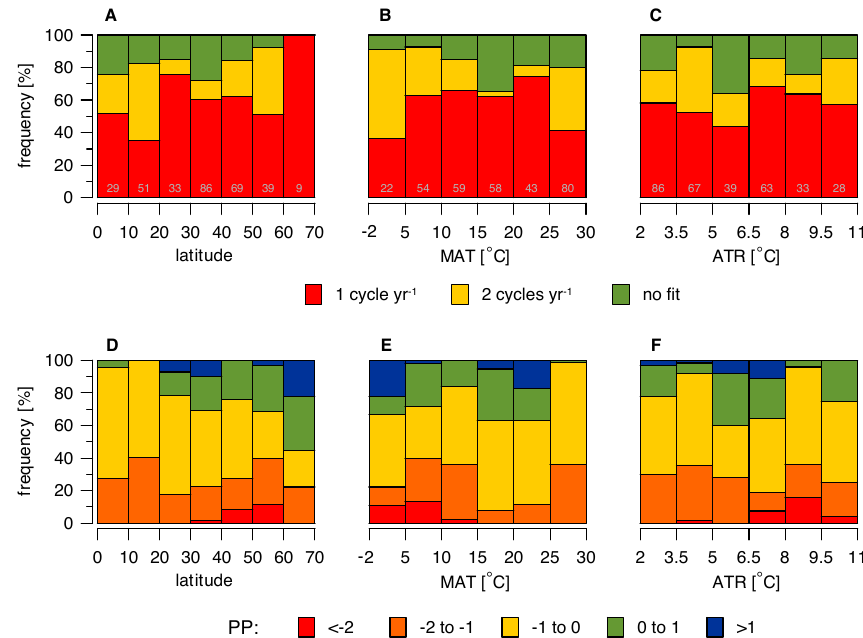
Figure 4. General patterns in shell fluxes. Top row: proportion of annual shell flux patterns showing seasonality and those characterised by one or two cycles per year vs. absolute latitude (a) , mean annual temperature (b) and annual temperature range (c) . Numbers denote sample size ( n ). Bottom row: peak prominence distribution vs. same parameters as